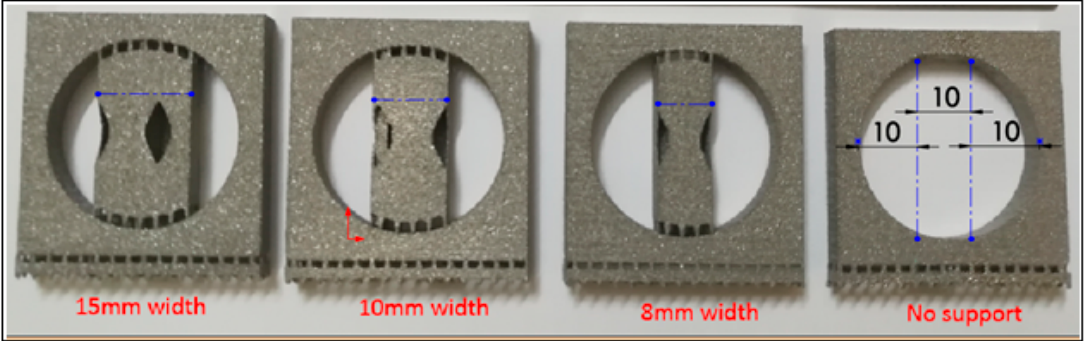
Figure 19. Holes with different segmentation levels of support structures.